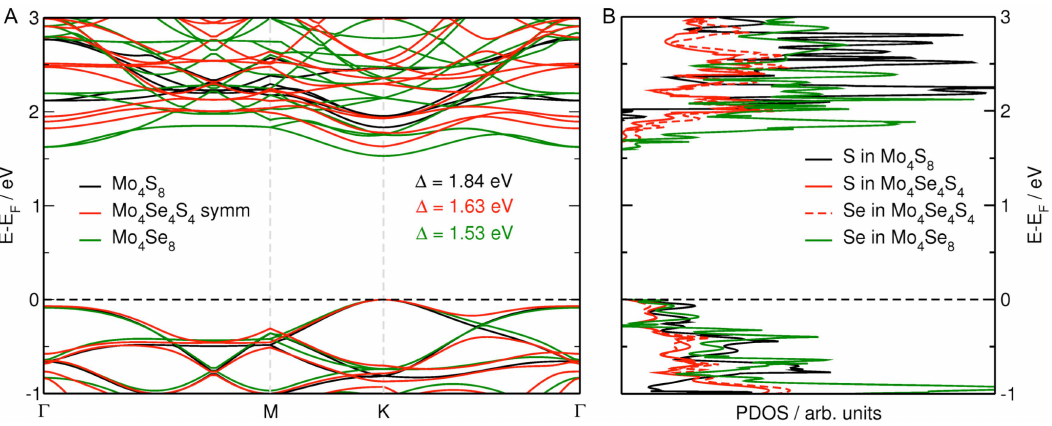
Figure 10. Electronic band structure ( A ) and density of states ( B ) of MoS 2 , MoSe 2 and MoSeS systems. The fundamental band gaps are indicated. The projection of states is shown on chalcogen atoms. The Fermi level is shifted to the valence band maximum. No spin-orbit coupling is taken into account. Th projected density of states shows that once again, the doping atoms are well incorporated into the host materials, with both S and Se atoms contributing equally to the states close to the Fermi level. The spin-orbit corrected calculations show that also Se-based alloys exhibit large spin-orbit